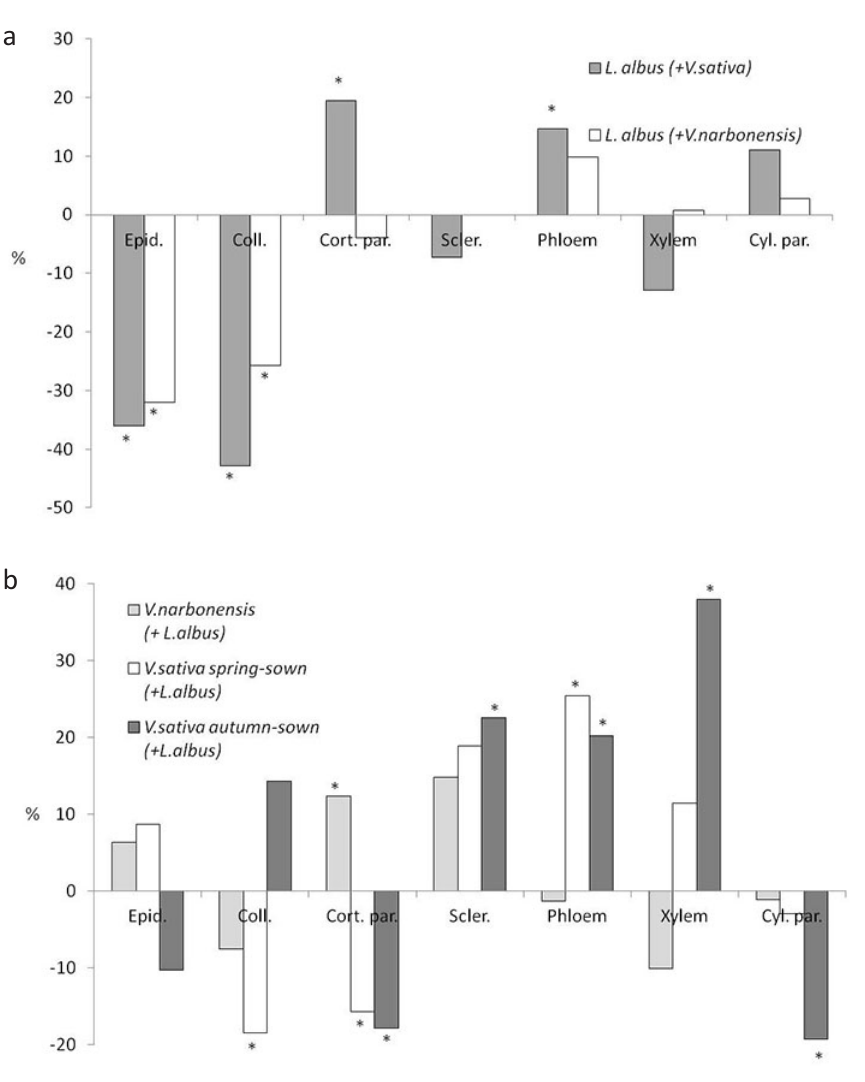
Fig. 3. Volume densities of stem tissues of intercropped plants, expressed as a percentage of the values obtained for the control plants, grown as sole stands: (a) L. albus ; (b) V. narbonensis , V. sativa spring- sown and V. sativa